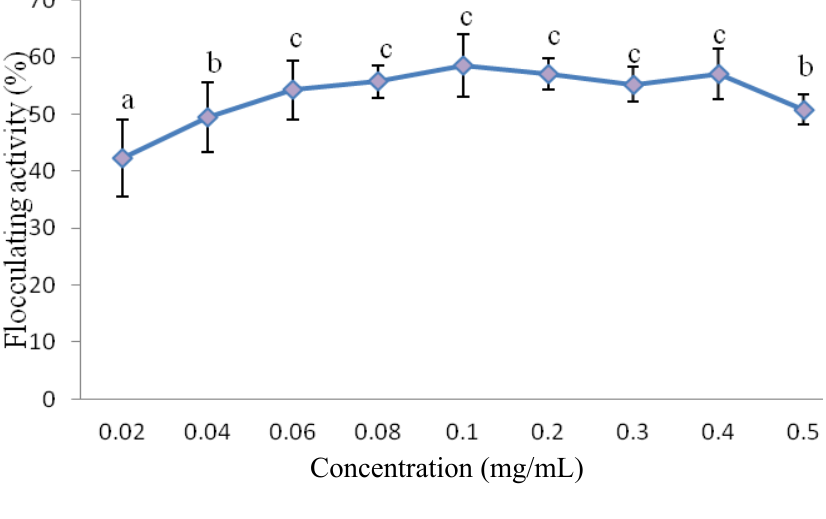
Figure 2. Effect of bioflocculant concentration on the flocculating activity of the bioflocculant produced by a consortium ( Halomonas sp. Okoh and Micrococcus sp. Leo). Flocculating activities with different letters are significantly different ( p < 0.05) from each